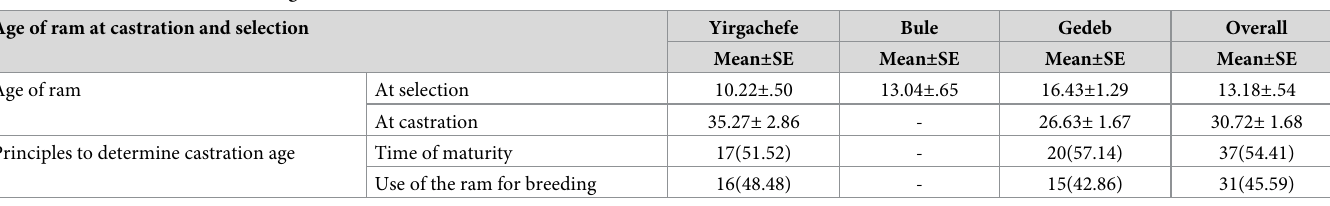
Table 13. Selection and castration age of